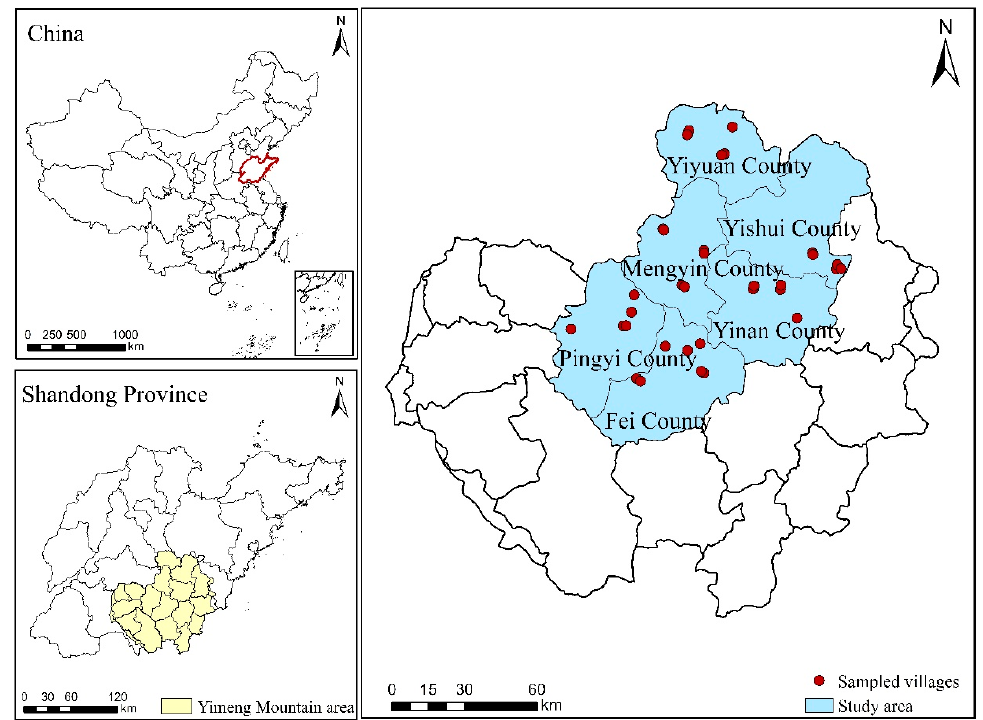
Figure 1. Location of the study area.